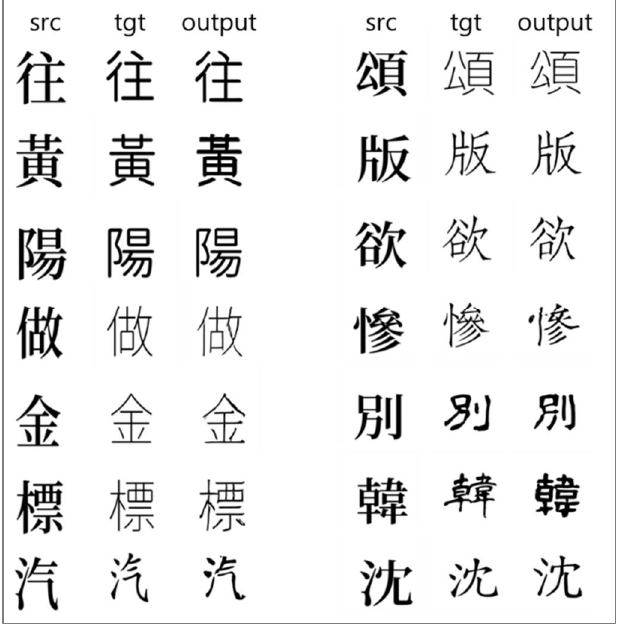
Figure 2. Example of Chinese characters generated (out) by CCFont model in the style of the target character (tgt) based on the character input (src).